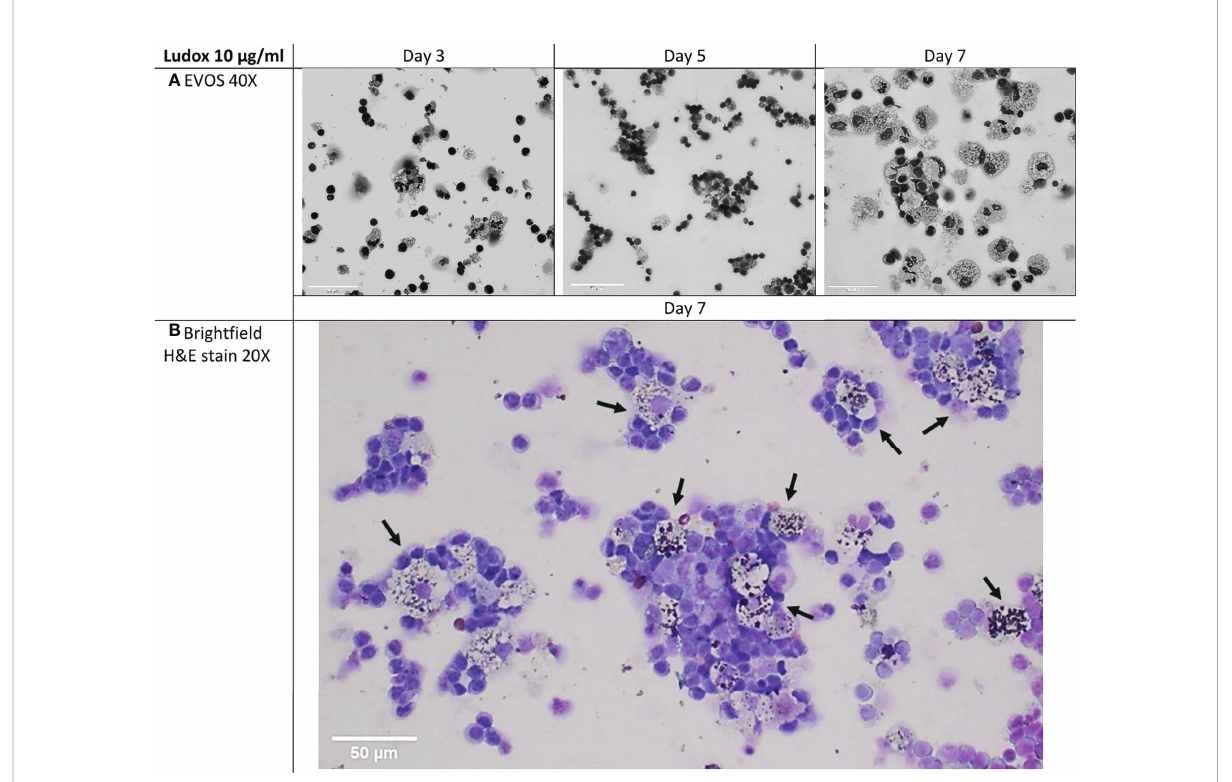
FIGURE 5 (A, B) Cellular makeup of developing aggregates over select time-points. Cytospins of developing granulomatous aggregates that were stimulated with 10 µg/ml of Ludox, were H&E stained on days 3, 5 and 7 within the silicotic patient group. EVOS images were captured at 40x, scale bar: 50µm (A) and compared against bright fi eld imaging at 20x, scale bar: 50µm (B) . By day 7, loosely organized granulomatous structures were retained and most of the macrophages found within these structures contained Ludox silica particles (black arrows) and were surrounded by layers of lymphocytes (Bright fi eld, 20x). H&E, hematoxylin and